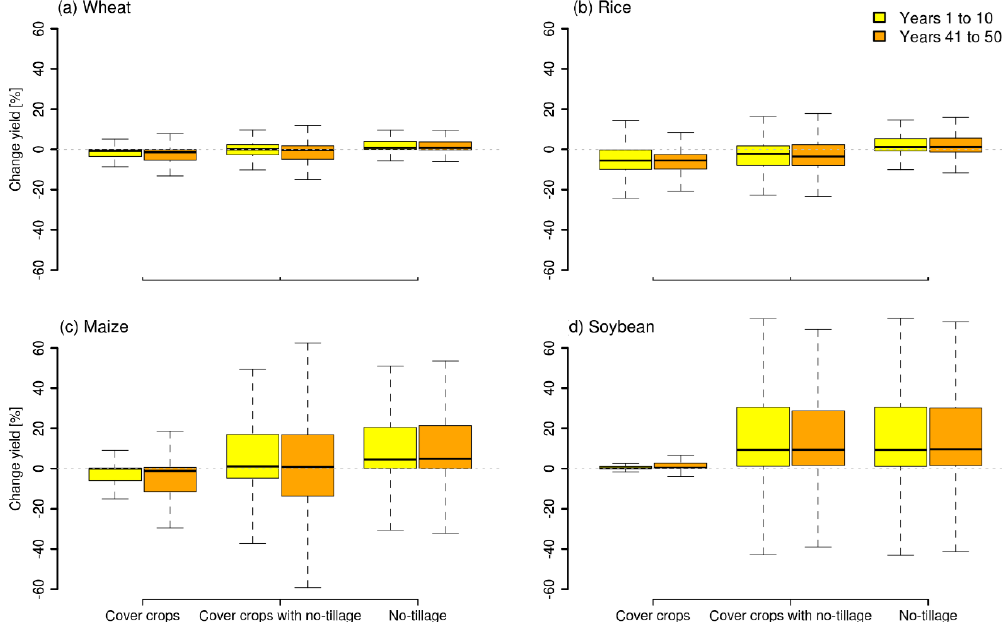
Figure 5. Panels (a) – (d) displaying changes in wheat, rice, maize, and soybean average yields as boxplots of relative differences in percent (%) area-weighted by crop-specific physical cropland, due to alternative management practices (CC, CCNT, and NT) compared to the baseline scenario (REF) for the first (left bars, yellow) and last decades (right bars, orange) of the 50-year simulation period. Boxes’ black mid-lines indicate the spatial median across the distribution of responses, the lower and upper edges of the boxes the first and third quartiles, and whiskers extending both to the minimum and maximum values within 1.5 times the interquartile range from each Q1 and Q3 (outliers, defined as values outside this range are not shown here). The boxplots show the distribution of calculated responses across total crop-specific irrigated and rainfed physical cropland used for the year 2010 for wheat ( ∼ 333 × 10 6 ha), maize ( ∼ 369 × 10 6 ha), rice ( ∼ 132 × 10 6 ha), and soybean ( ∼ 94 × 10 6 ha). Irrigated shares of total global crop-specific physical cropland were 16% for wheat, 12% for maize, 35% for rice, and 11% for soybean cropping system area (Sect.